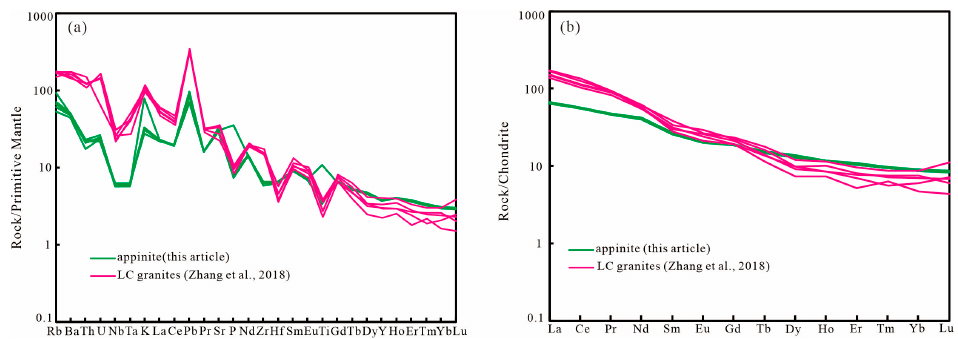
Figure 7. Chondrite-normalized REE patterns ( a ) and primitive mantle (PM) normalized trace element spider diagrams ( b ) for the Triassic Laocheng appinite. The data of the Laocheng granite was from Zhang et al. [26].